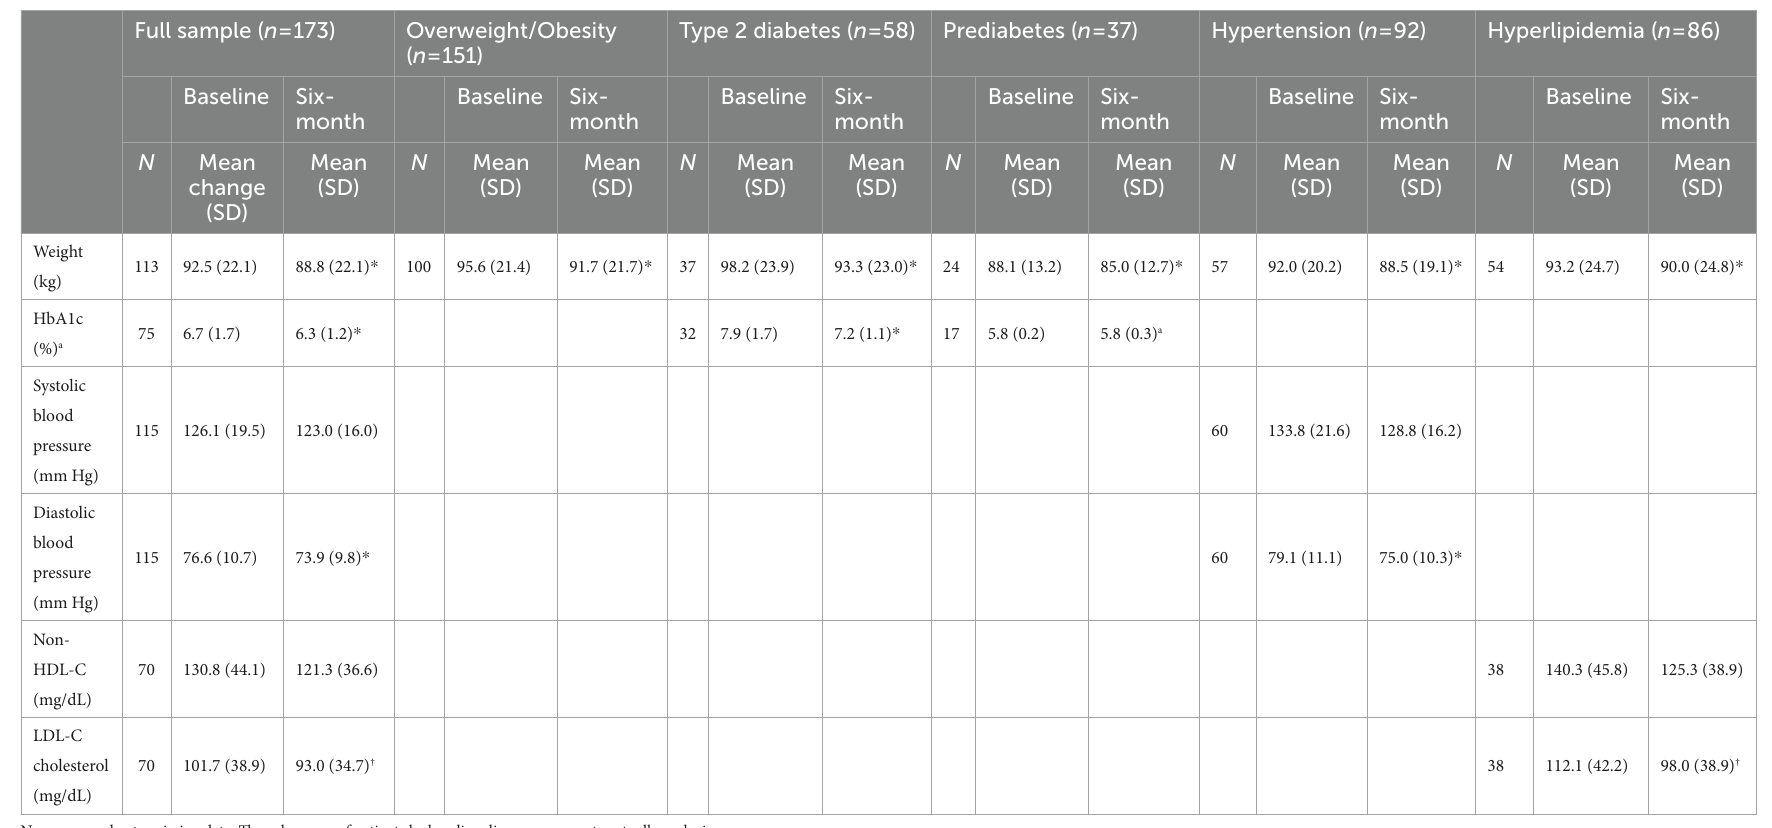
TABLE 2 Clinical outcomes for full sample and by baseline